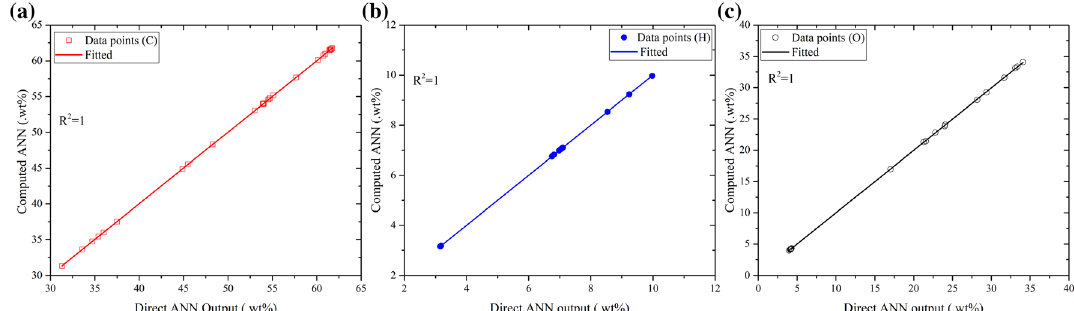
Fig. 4 Comparison of the ANN mathematical models with the direct ANN simulation